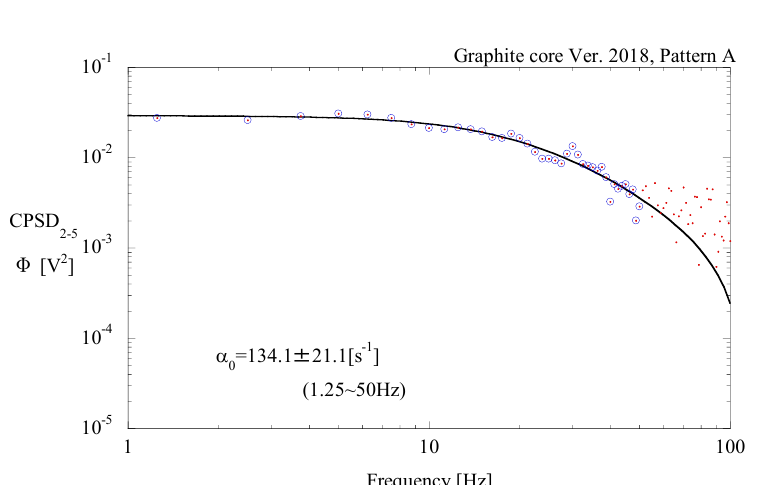
Figure 6. Cross - power spectral density between B2 and B5 in rod pattern A (subcritical state).